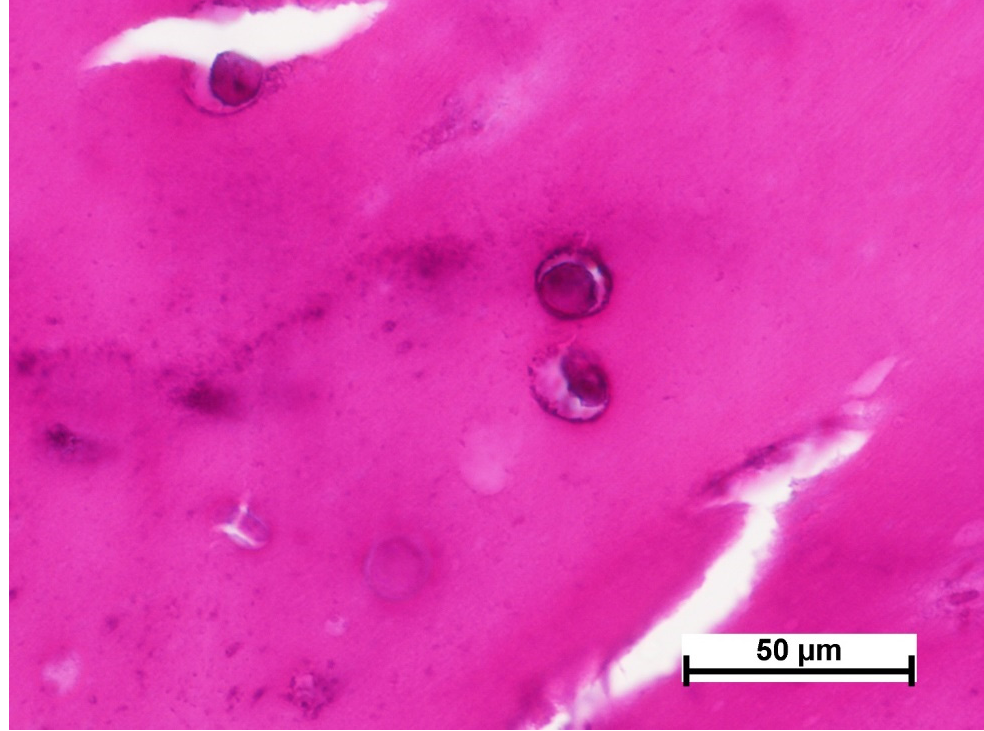
Figure 8. MSCs in cell scaffold 7 days after implantation. Staining with hematoxylin–eosin. By day 14 after CCS implantation, as in the case of the cell-free material, connective tissue had completely replaced the matrix. The implant site showed dense irregular